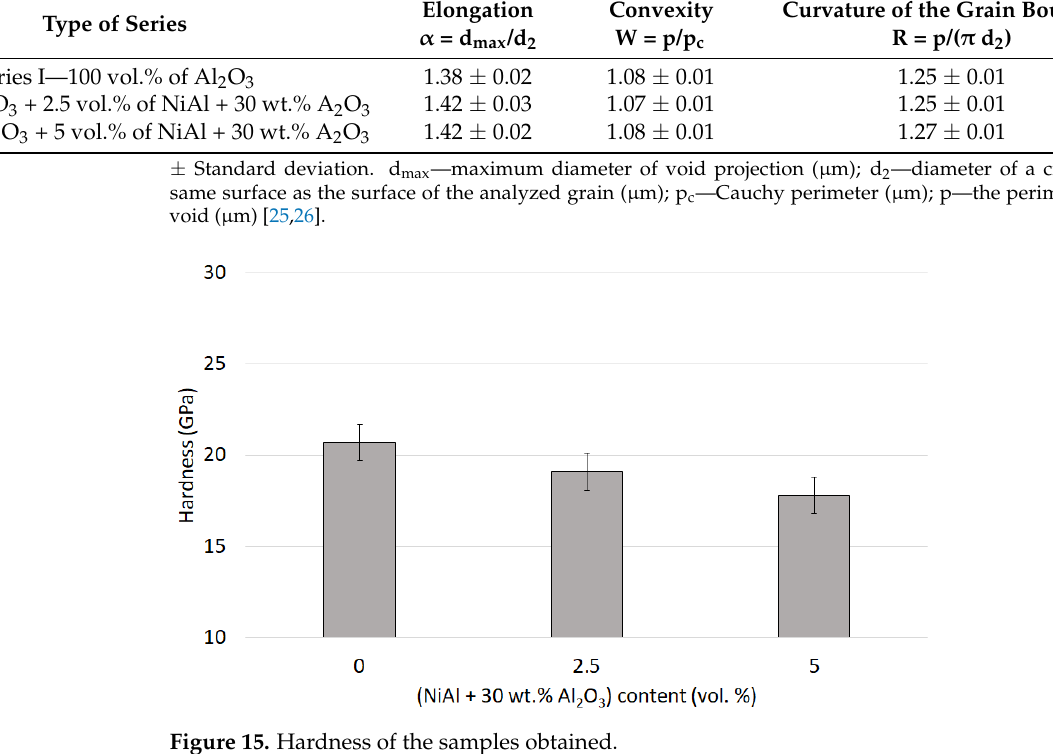
Figure 16. Fracture toughness of the samples obtained.